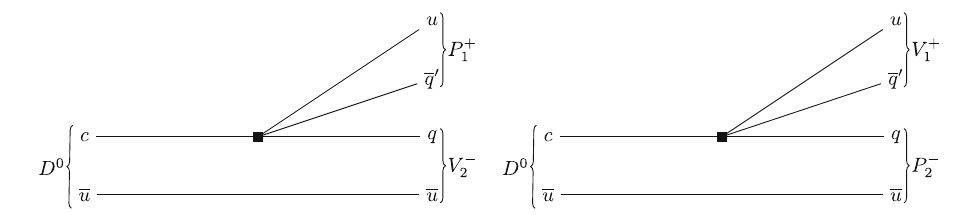
Fig. 5 The dominant diagrams to D → V P ( → PP γ) in the λ QCD / m c and α s expansion. At order α 0 s QCDF reproduces the naive factorization [9]. The diagrams are shown for charged final state mesons. For the final state with uncharged mesons the u and q quark have to be